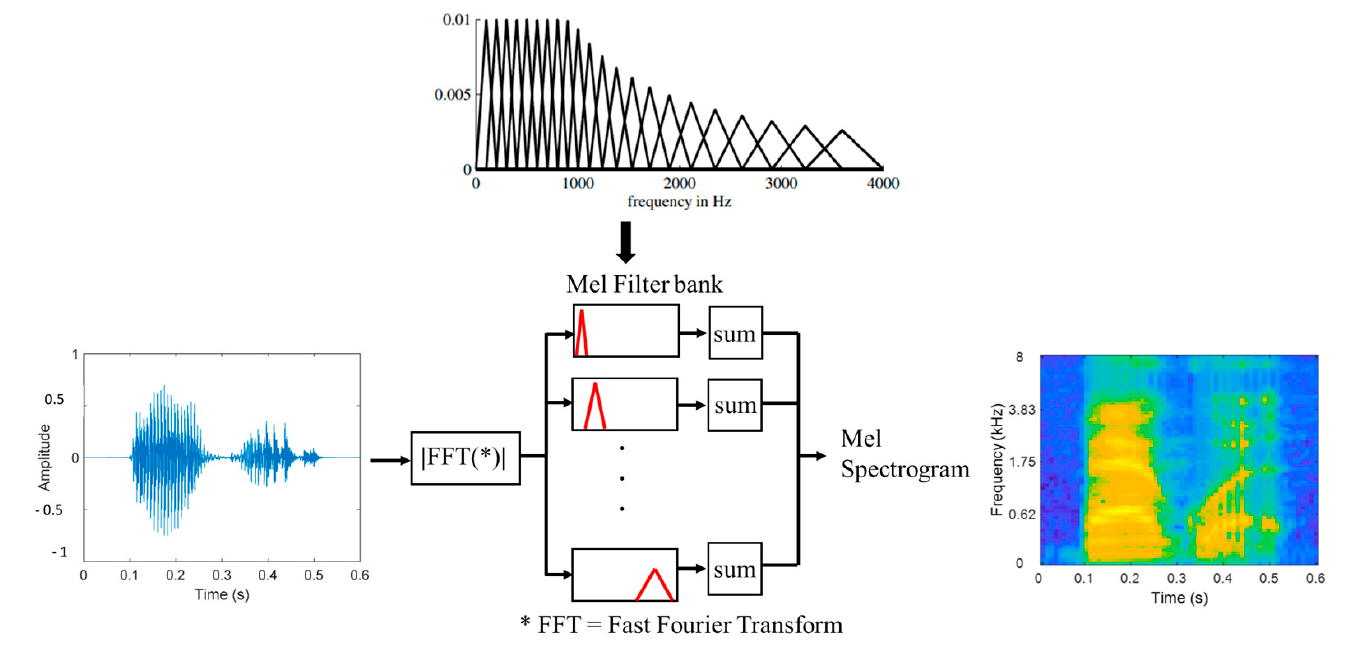
Figure 5. Mel spectrogram operation.